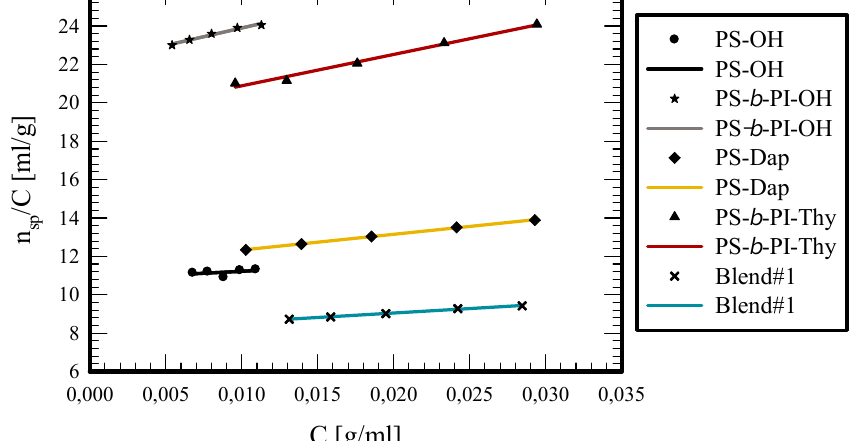
Figure 13. Huggins plots for samples PS ‐ OH, PS ‐ b ‐ PI ‐ OH, PS ‐ Dap, PS ‐ b ‐ PI ‐ Thy, and Blend #1.